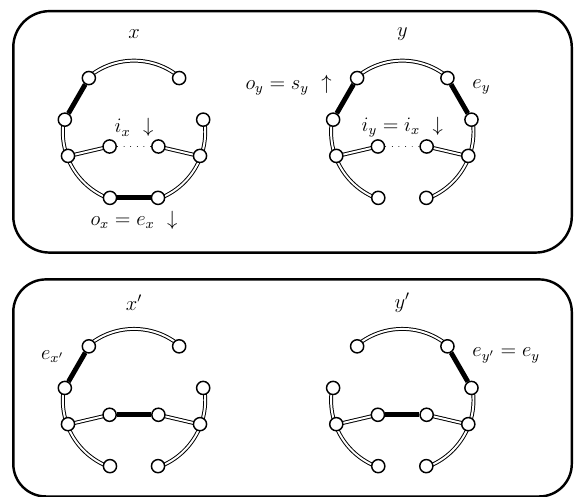
Figure 12: Case 4. b .i when B fails and s y /